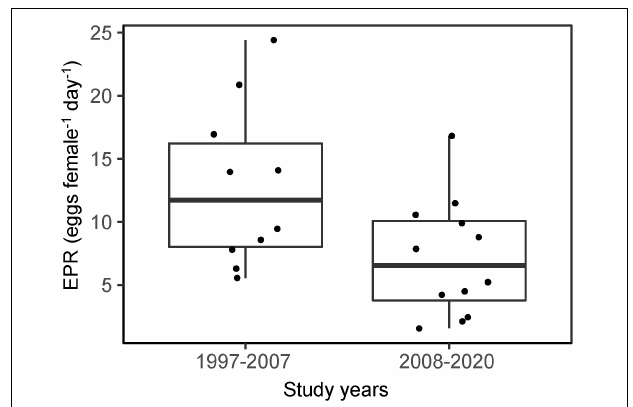
FIGURE 5 | Jitter and box plot of individual egg production rates (eggs female − 1 day − 1 ) on the Faroe shelf in late April during the time periods 1997–2007 and 2008–2020. The line in the middle of the boxes represents the median, and the lower and upper ends of the box are the 25 and 75% quartiles, respectively. The lower and upper whiskers are constructed according to R’s default box plot code (R Core Team, 2018). The points represent